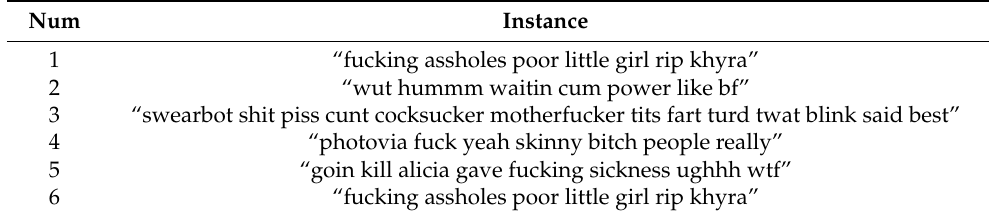
Table 7. Samples of instances connotating the criminality